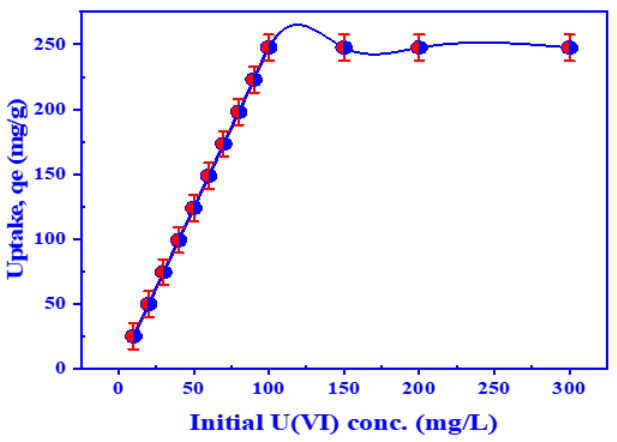
Figure 8. The influence of initial U(VI) ion concentration on the retention of uranium by HTIP che- lating ligand. (pH 3.0, HTIP/CHCl 3 conc.: 0.99 × 10 − 3 mol/L (10 mg/25 mL), time: 30 min, A/O 1:1, T: 25 °C).